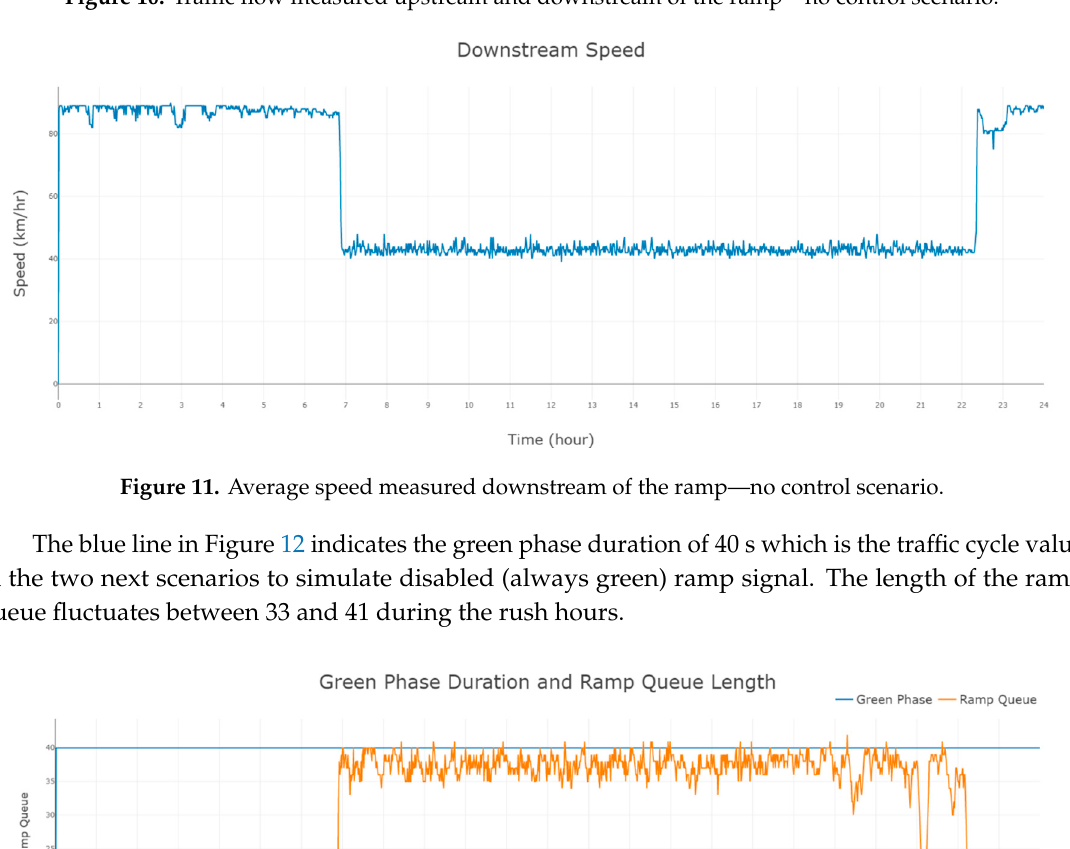
Figure 10. Traffic flow measured upstream and downstream of the ramp—no control scenario.